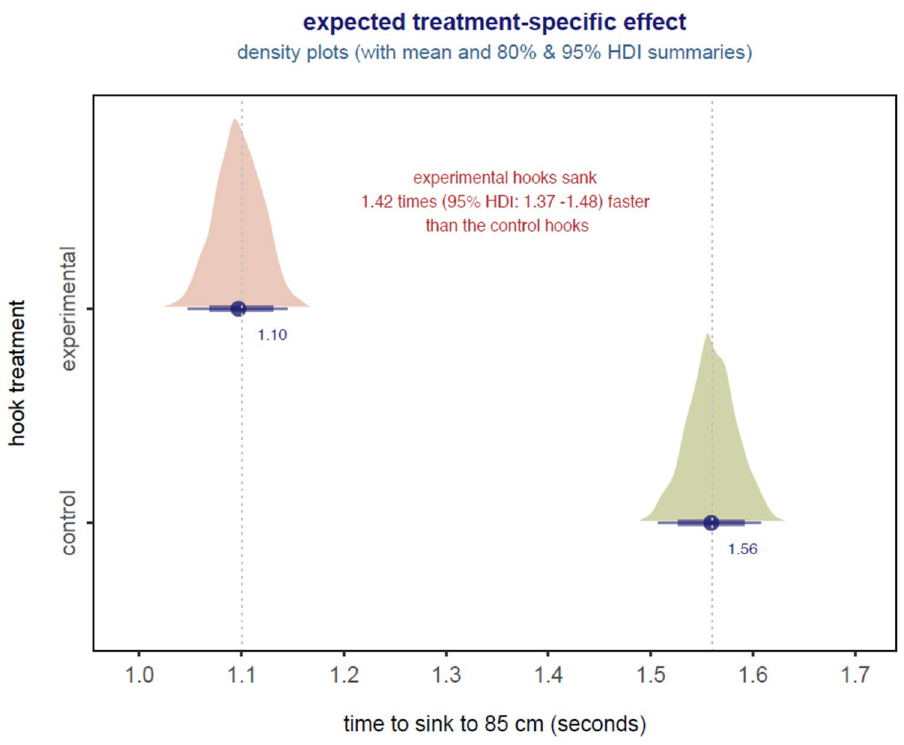
Figure 2. Summary of the estimated hook treatment effect derived from the GLMM for the 51 paired sink rate trails. Colored polygon shows the density distribution summary for that parameter, solid dot (+ numeric label) = estimated mean of the density polygon, thick horizontal line below each polygon shows the 80% HDI for the posterior density polygon while the thin horizontal line is the 95%